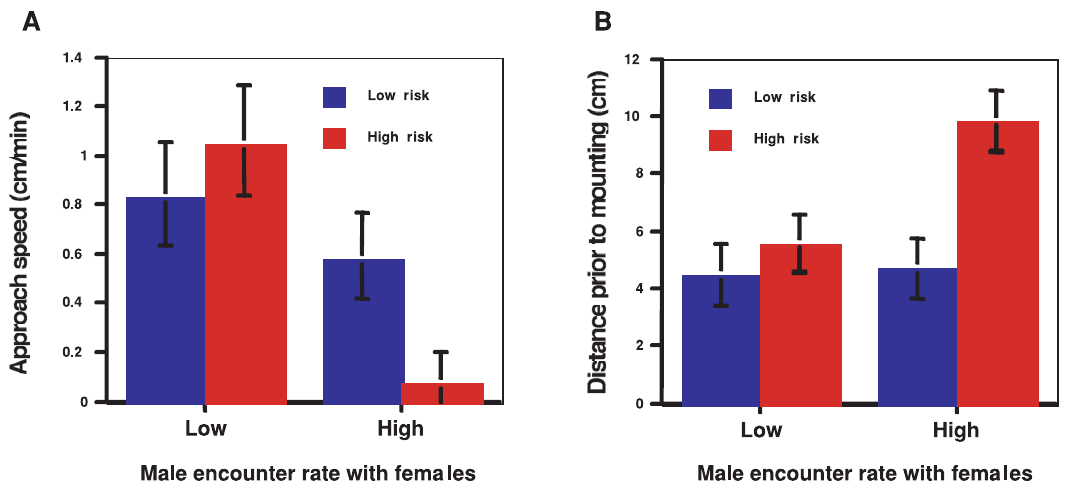
Figure 1. Male approach toward females. ( A ) Males with high female encounter rate approached high-risk females more slowly than they approached low-risk females, whereas males with low female encounter rate showed no difference in approach rate. ( B ) Males with high access to females approached remained farther away from high-risk females but males with low encounter rate approached equally closely to low- and high- risk females.